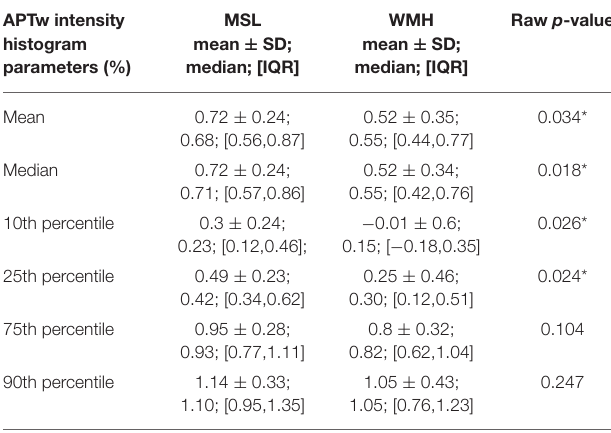
Mean ± standard deviation (SD), median and interquartile range (IQR) are shown. Significant p values using the Benjamini & Hochberg procedure with a false discovery rate of 0.10 are marked with a star ( *